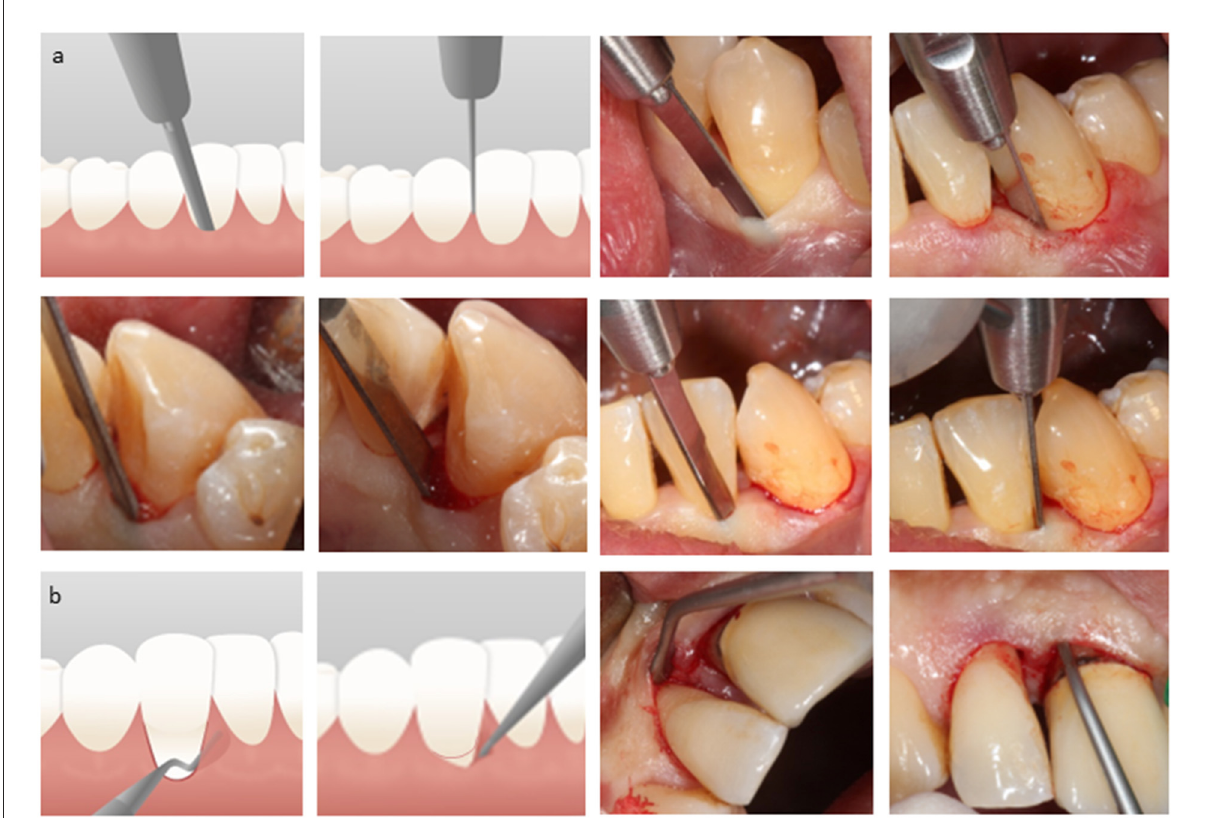
FIGURE1 Closed surgical technique: (a) strictly intrasulcular incisions; dissection of the periodontal attachment of the adjacent teeth related to the interdental defect leaving the interdental papilla intact; a microsurgical blade is used (b) full-thickness gingival flaps are prepared vertically and horizontally by sharp elevators; flaps are retracted from the alveolar bone in a “closed” manner to obtain access to the root surface and the osseous defect; the papilla is not dissected; gingival tissues including the papilla are mobilized via tunneling interdentally (buccal-lingual direction) using dedicated elevators; granulation tissue is not intentionally excised; retraction of flaps does not extend beyond the mucogingival line, unless required to obtain access; following careful instrumentation, the site is irrigated with saline and flaps are repositioned without